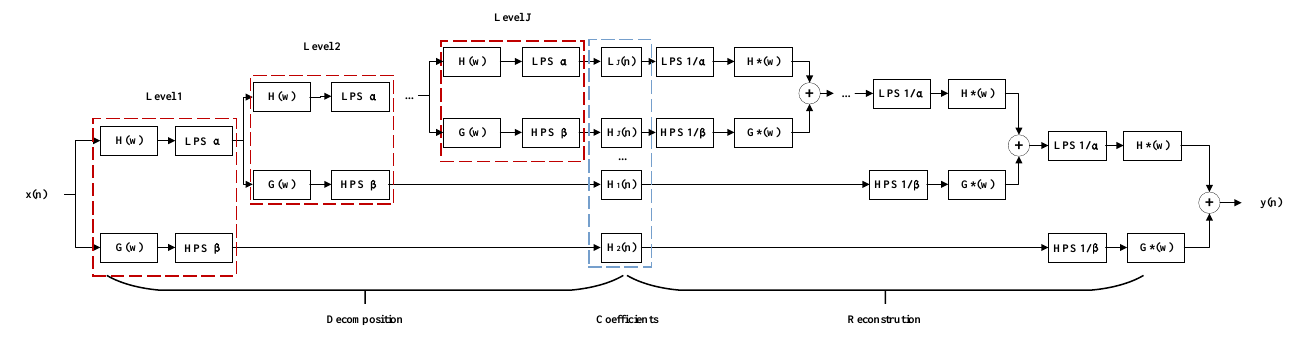
Figure 3. The analysis and synthesis filter banks for TQWT.